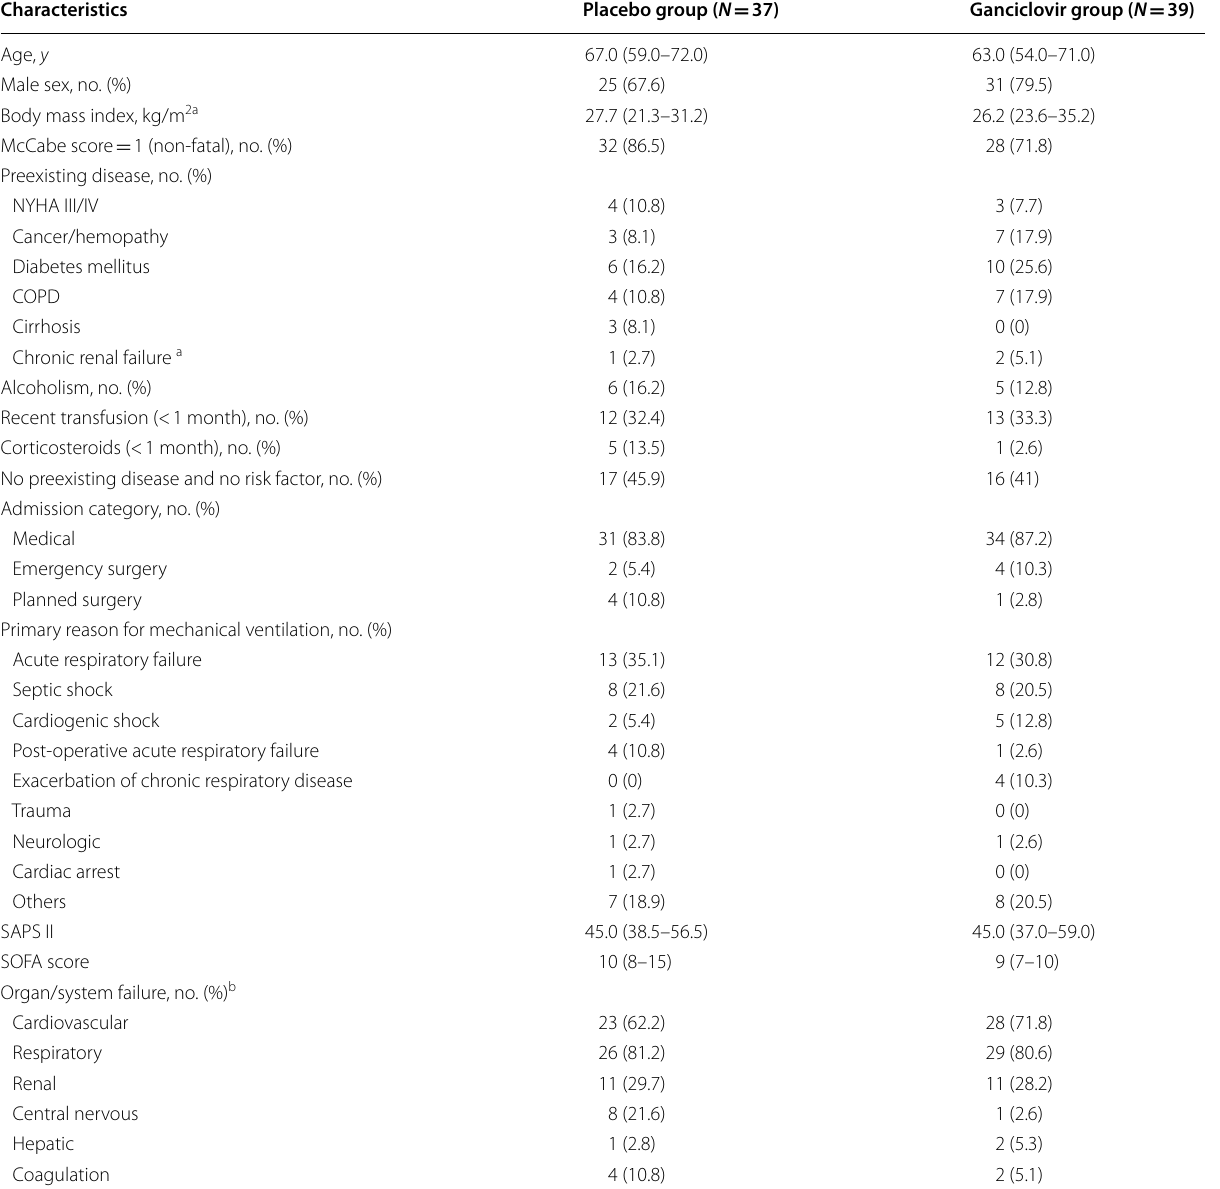
Table 1 Patient characteristics at ICU